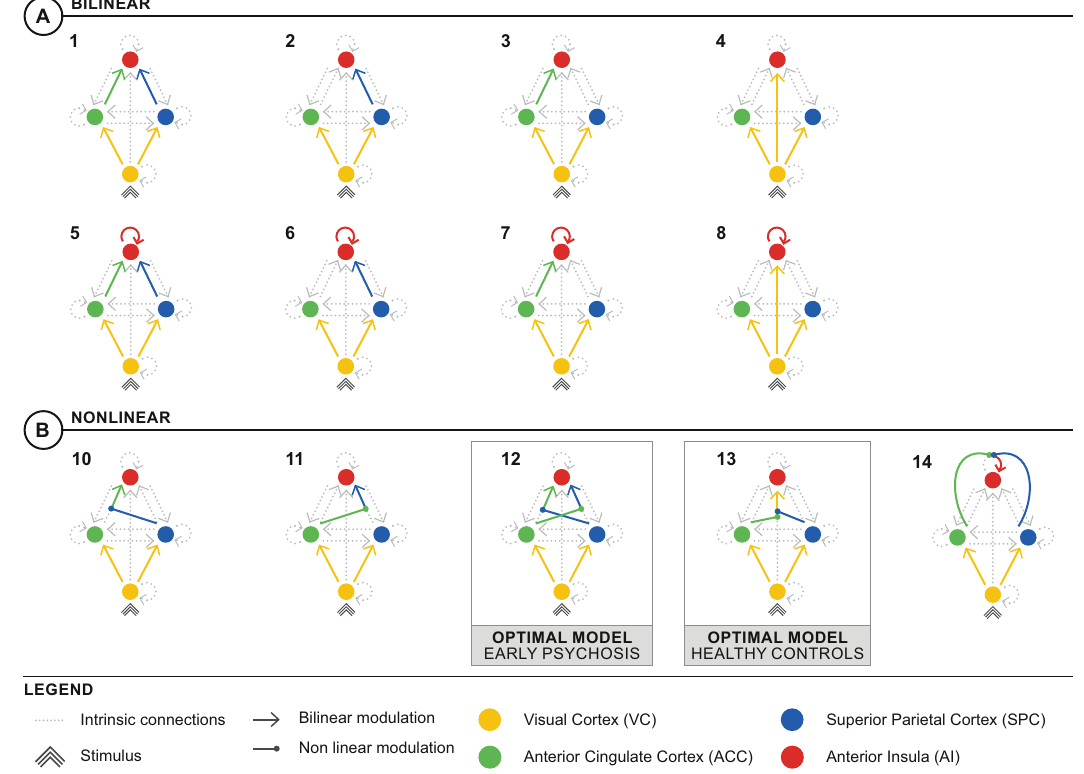
Fig. 2 Model space. Models for the DCM were used to explore the hypothesized link between neural and behavioral task effects. Fourteen models: A 8 bilinear family models (exclusively linear, additive modulations with or without AI self-connection modulation), B 5 nonlinear family models (linear, additive modulations from VC and nonlinear, gated modulations from ACC and SPC, with or without AI self-connection modulation), and 1 null model (not shown) were included in the DCM model space as parsimonious hypotheses of modulations that explained the group-by-condition effect. The results of the BMS indicated that the optimal model for EP group was model 12 (see online Supplementary Fig. S1B) and the optimal model for the control group was model 13 (see online supplementary Fig.